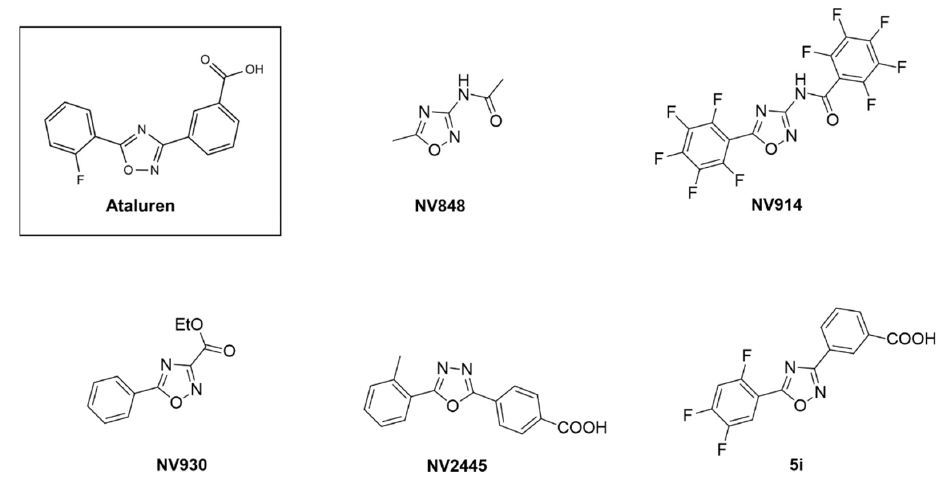
Figure 1. Chemical structures of ataluren derivatives. Lymphoblastoid cell lines (LCL) were previously generated from B cells isolated from four different SDS patients carrying the nonsense mutation c.183-184TA>CT in SBDS [24]. Cells were incubated with 2.5 µ M ataluren, or 10 µ M analogues NV848, NV914, NV930, NV2445, and 5i, or vehicle alone (DMSO) for 24 h. These concentrations were previously optimized by other studies conducted both in SDS [16] and CF [22,27,38] cell models. Among the analogues tested, only NV848 and NV914 significantly induced SBDS full- length protein resynthesis, similarly to ataluren, in LCL (Figure 2a,b). Normal LCLs (control) exhibited a 13-fold higher SBDS protein expression compared to SDS cells in the same condition (Figure 2b). Upon treatment with ataluren, NV848, and NV914, SBDS protein synthesis increased by 178%, 250%, and 319%, respectively (Figure 2b). In order